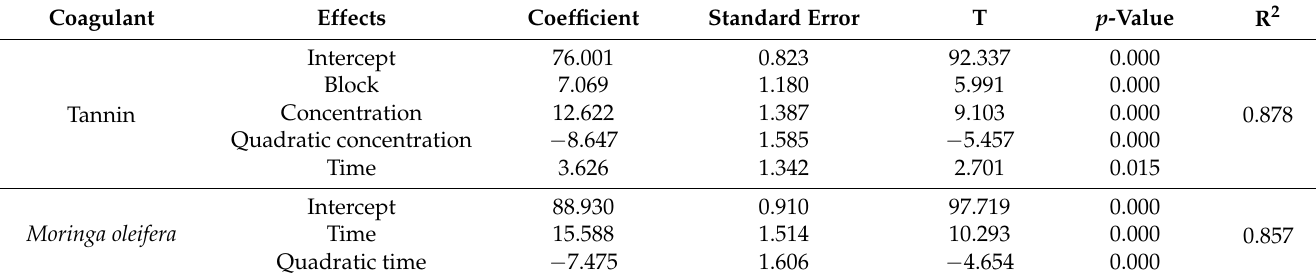
Table 6. Significant effects for the apparent color parameter for coagulation, flocculation, and sedi- mentation (C/F/S) process using tannin and Moringa oleifera in the presence and absence of magnetite.